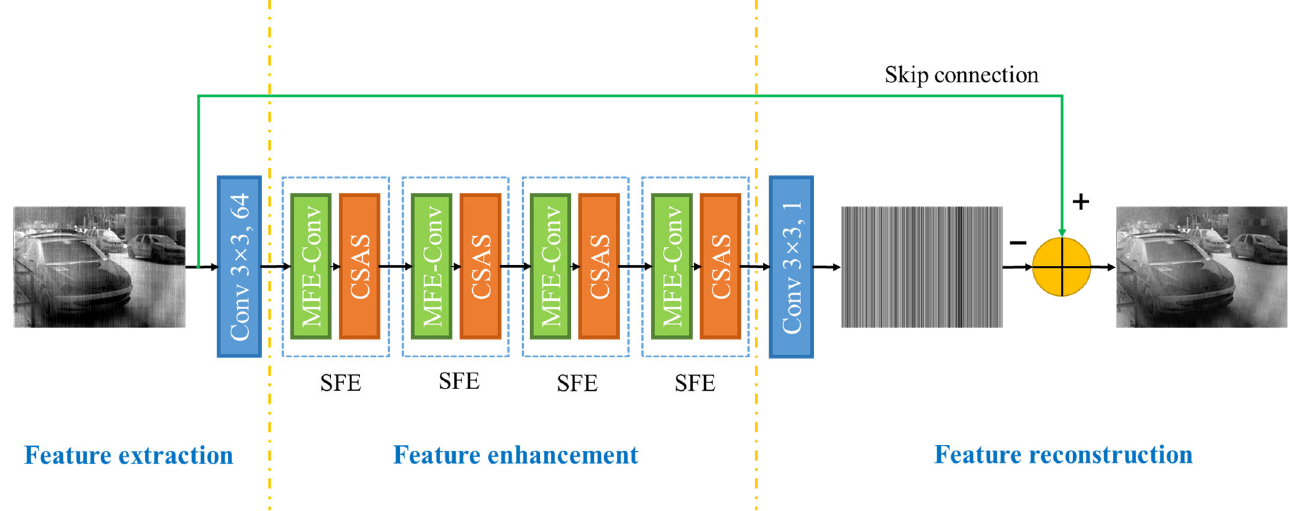
Figure 1. The network architecture of the proposed